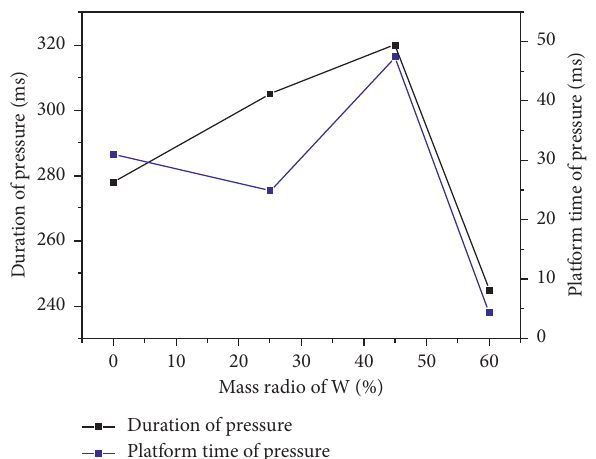
Figure 18: Comparison of the platform time and pressure duration for the Al/PTFE/W energetic jets with different W contents.